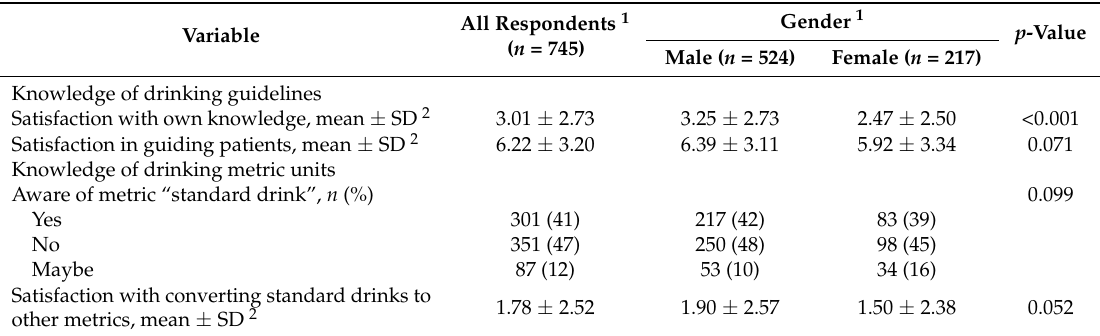
Table 2. Physicians’ self-reported knowledge and understanding of drinking metrics and guidelines.